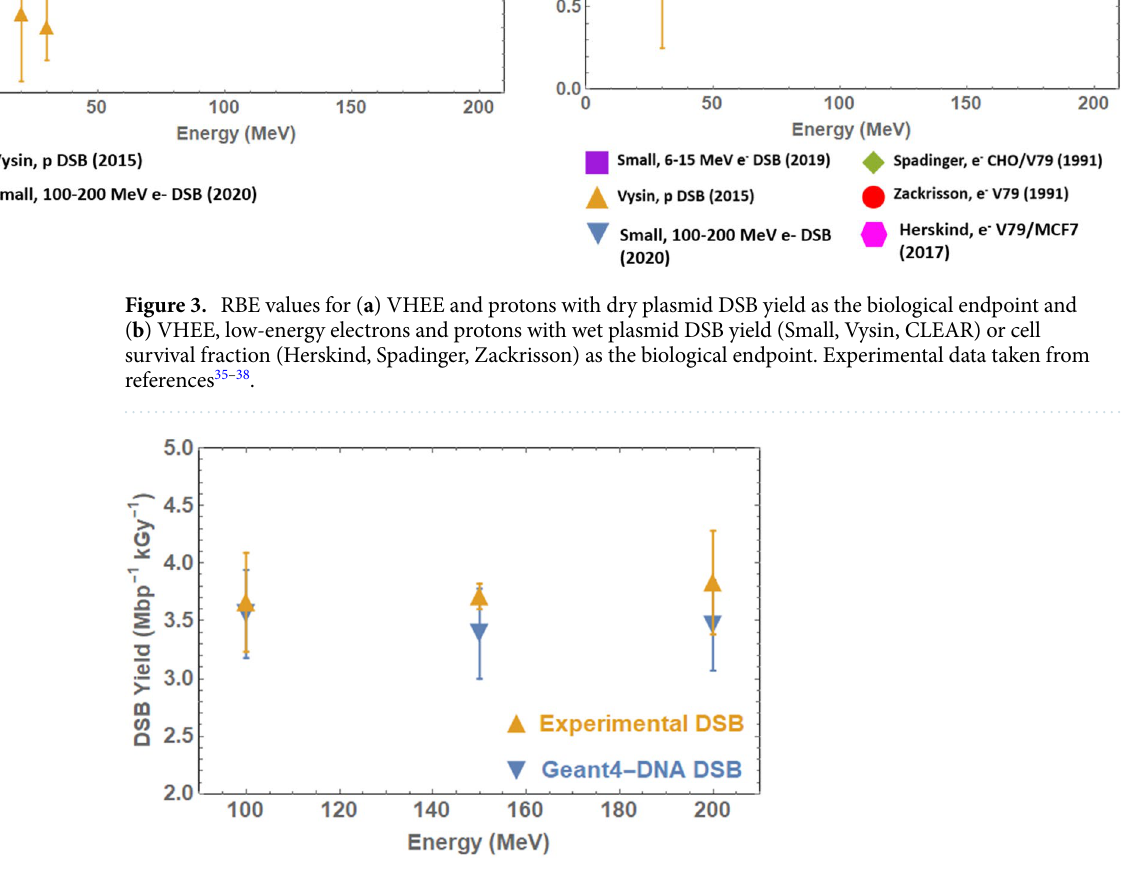
Figure 4. Double-strand break yields for experimental and computational plasmid DNA irradiation with 100–200 MeV electrons. Geant4-DNA simulation performed with half-cylinder DNA geometry with a 10 bp separation defined for DSB induction and damage determined by an energy threshold of 8.22 eV. Standard errors calculated based on 10 3